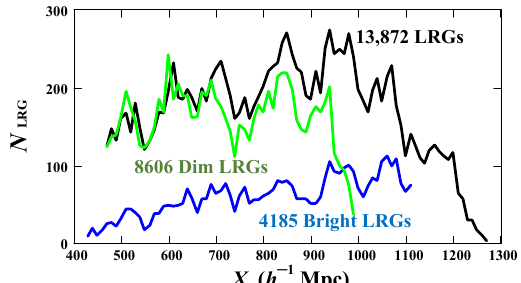
Figure 6. Three different distribution functions N LRG ≡ N X ( X 0 ) as a number of cumulative projec- tions on a selected axis X 0 ( α 0 , δ 0 ; see text) of the Cartesian LRG coordinates detected through six sectors (windows) in the sky shown in Figure 2. Characteristics of all three samples, DR7-Full (black line), DR7-Dim (green line) and DR7-Bright (blue line), are given in Table 1. The results of our calculations of the 1D power spectrum are represented in Figures